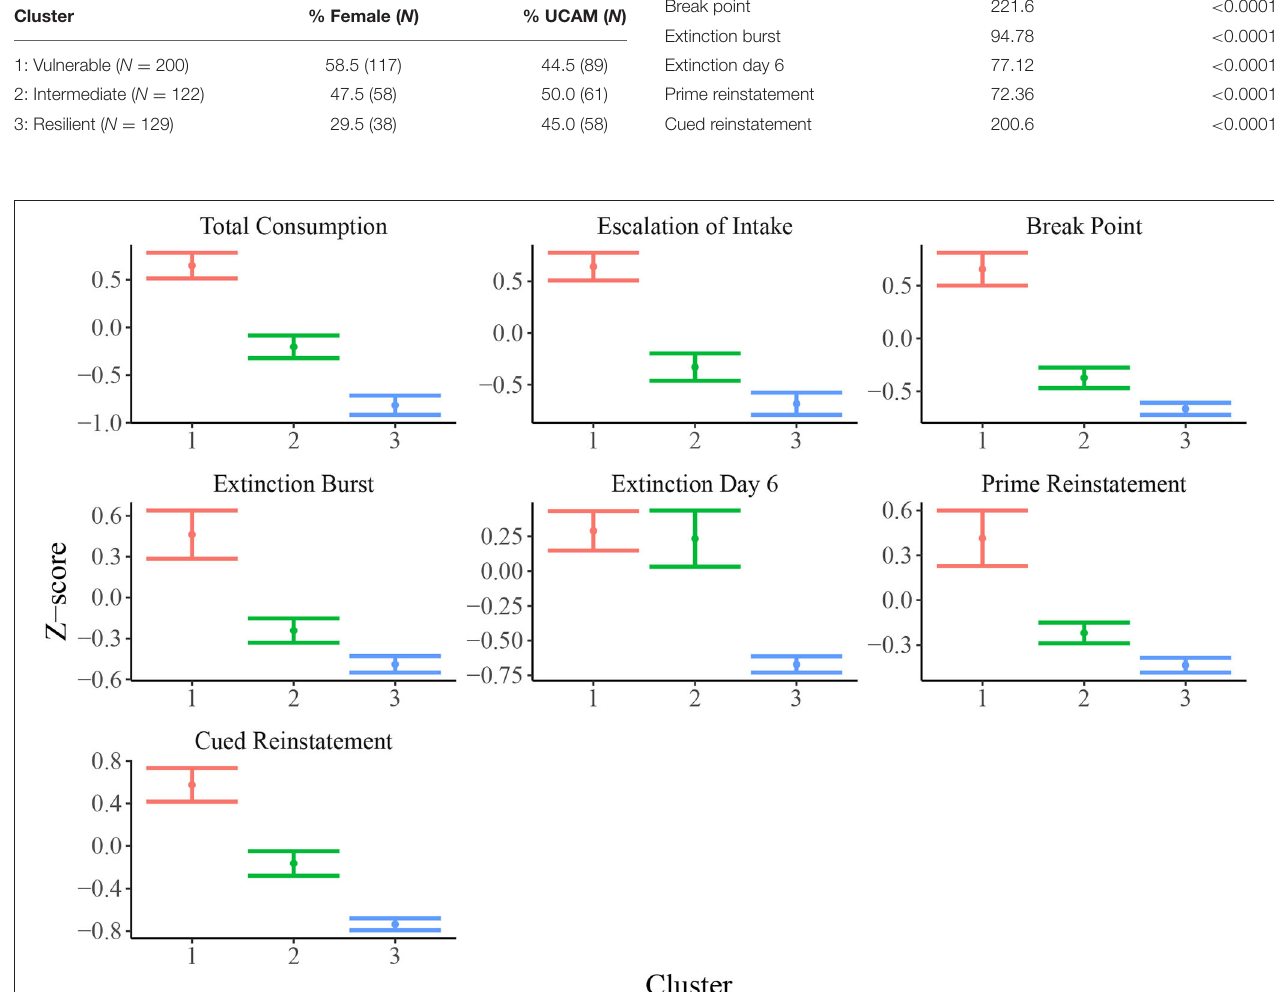
FIGURE 3 | Means and 95% confidence intervals for relevant behavioral measures (z-scored) in each cluster. Distributions of z-scored behavioral variables indicate evidence for vulnerable (cluster 1; N